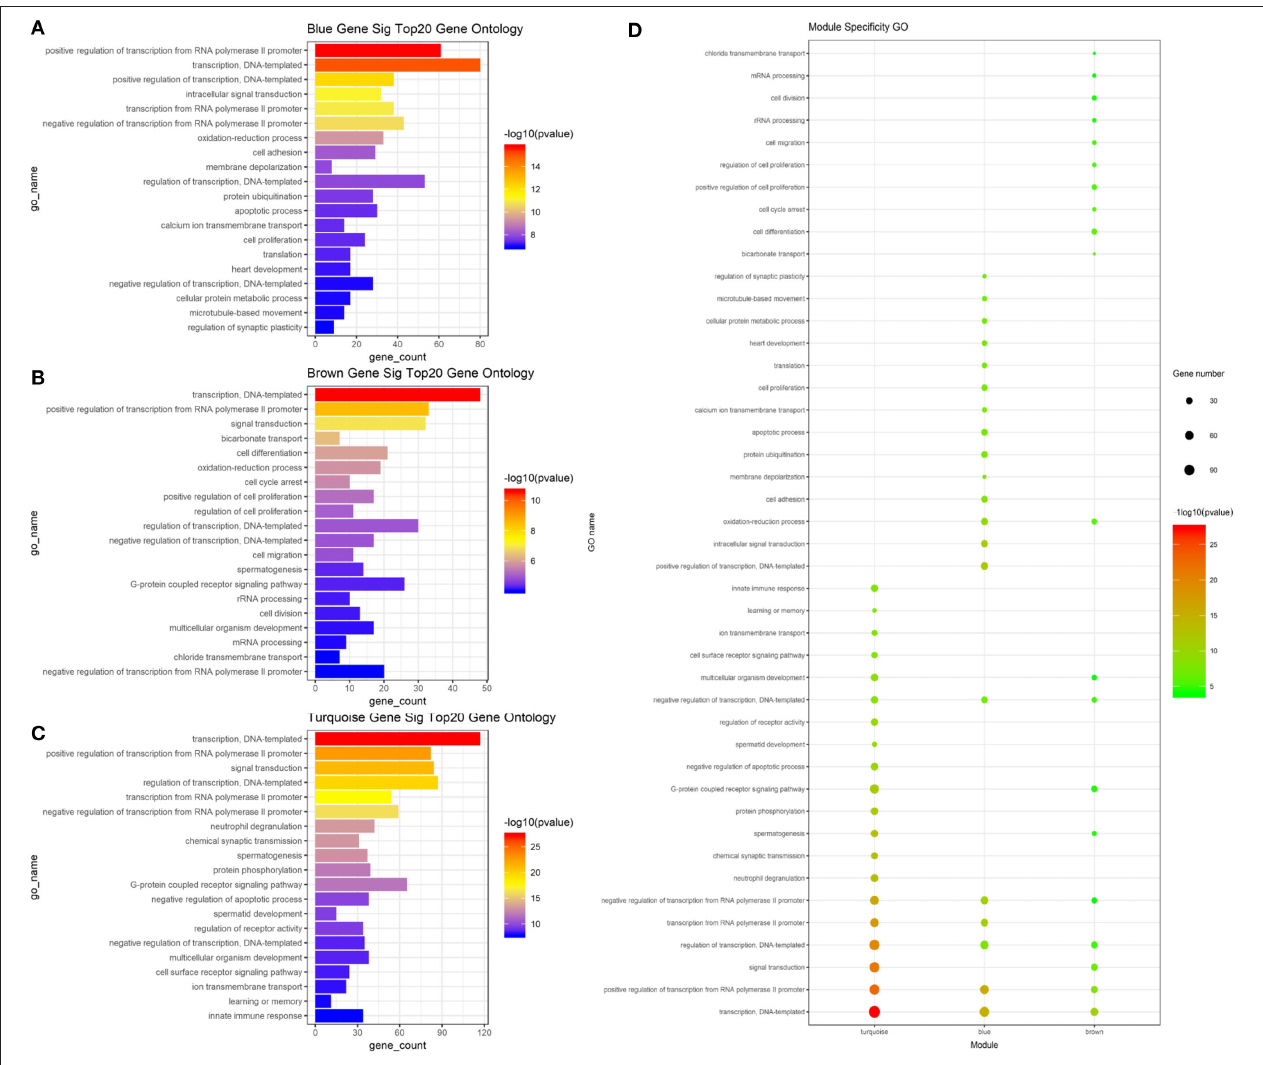
FIGURE 5 | Result of GO analysis about mRNA based on WGCNA. (A) Top 20 enriched gene ontologies in blue module (B) . Top 20 enriched gene ontologies in brown module. (C) Top 20 enriched gene ontologies in turquoise module. (D) Module specificity gene ontologies. The vertical axis shows the results of GO analysis, and the horizontal axis shows the different modules. The color of the round shape shows transitional values (log10 of q value), and the size shows the number of genes that were enriched. mRNA, messenger RNA; WGCNA, weighted gene co-expression network